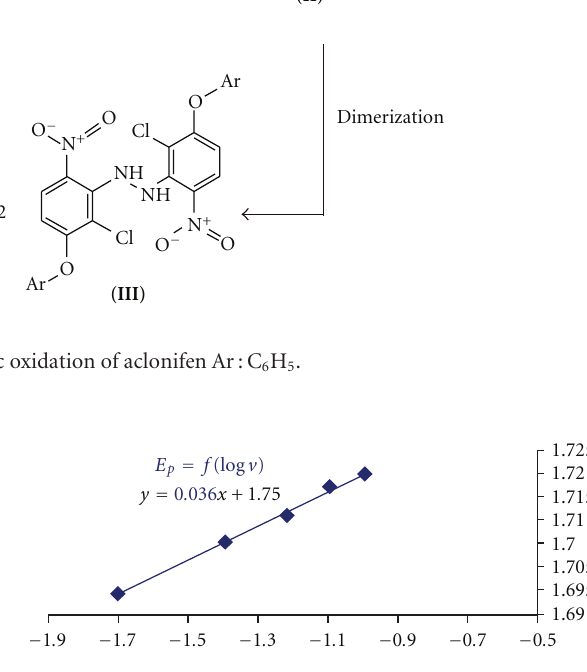
Figure 4: Aclonifen potential peak variation with scan rate C = 2 mM, reference: